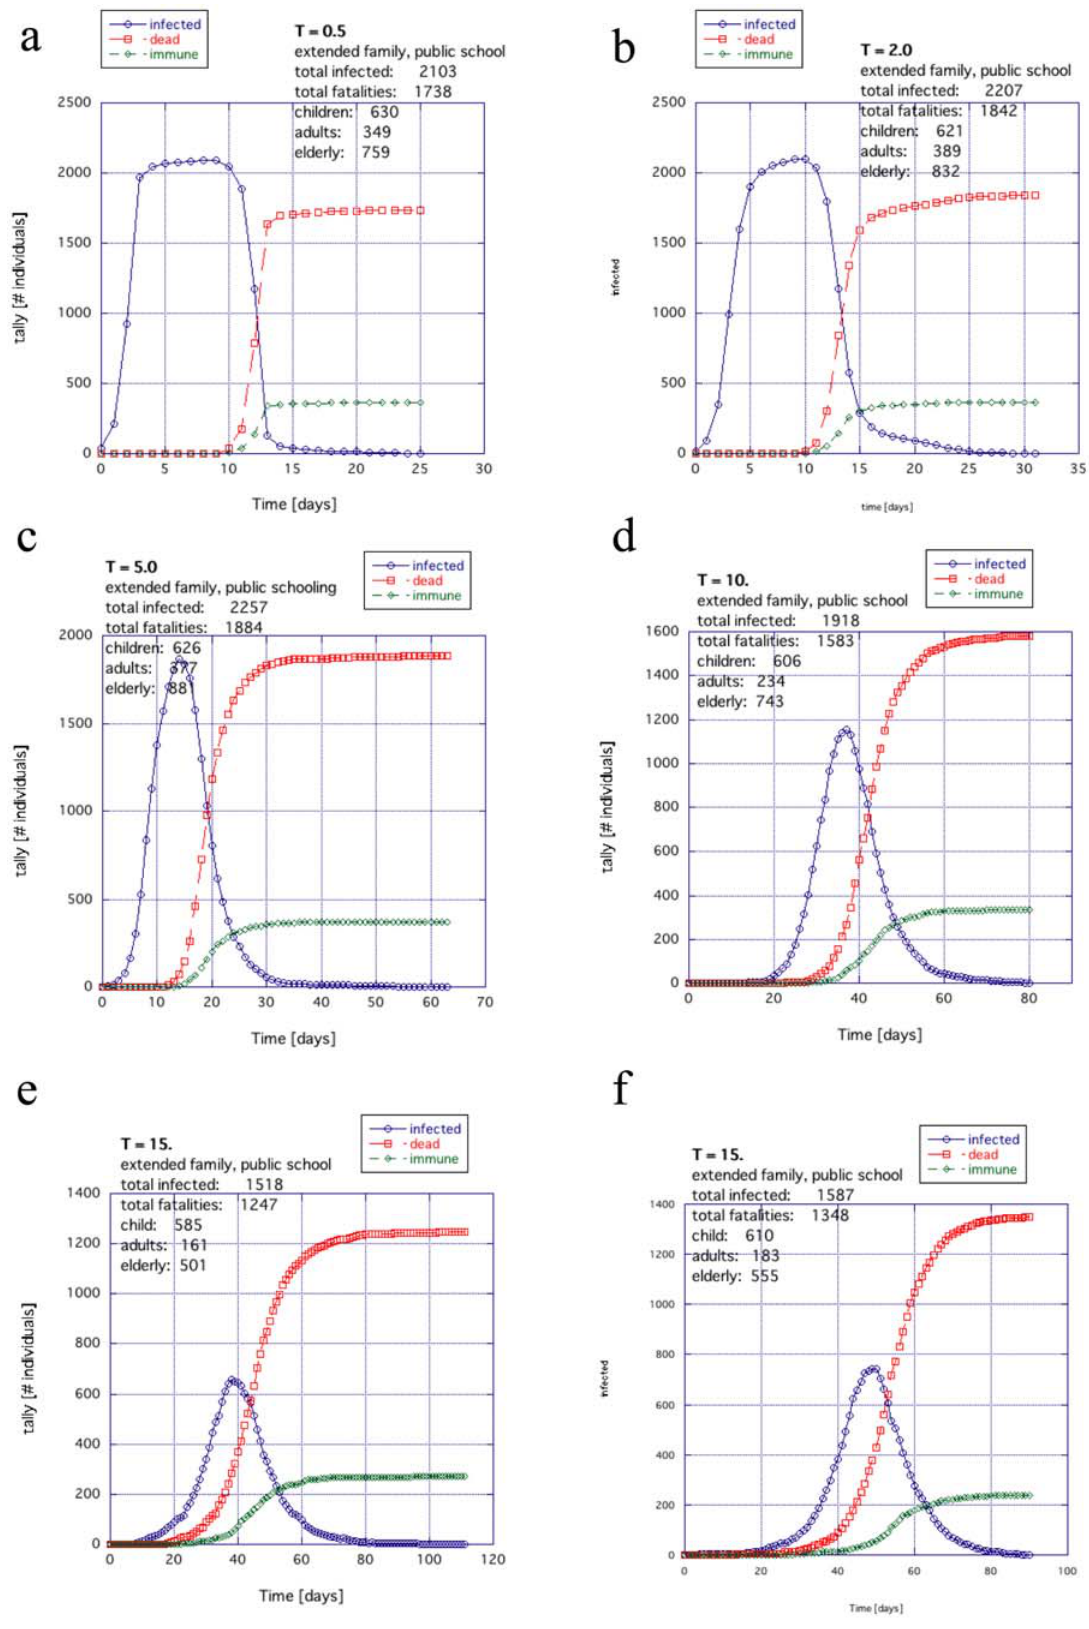
Figure 9. The general trend for temperature with the extended family example when the children go to public institutions: (a) T ~ 0 : 5 , (b) 2.0, (c) 5.0, (d) 10.0 and (e and f) 15.0.